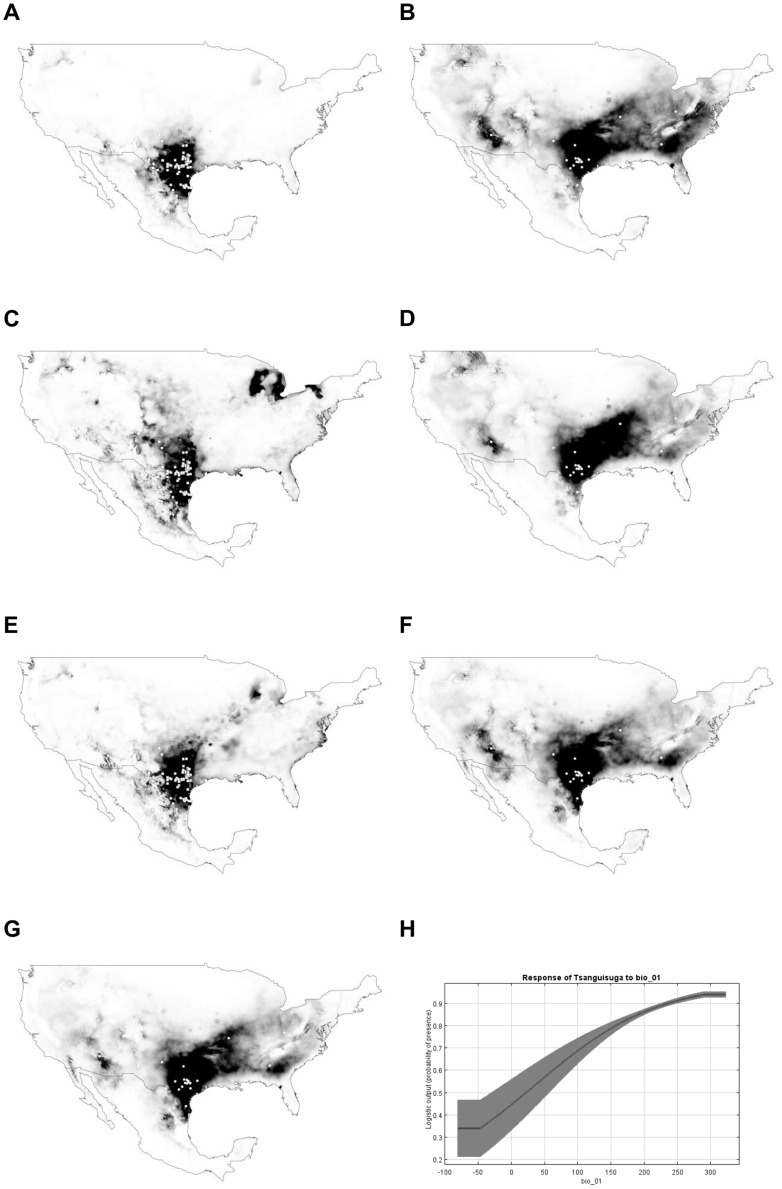
Present (A) and future (2050; B–G) potential distribution for Triatoma sanguisuga.All models predict a shift in the distribution of this species towards northern and eastern regions of Mexico and USA. Black color =  high suitable habitat vs. white color =  no suitable habitat for the species. General circulation models and climatic scenarios: B =  CCCMA-A2A; C =  CCCMA-B2A; D = CSIRO-A2A; E = CSIRO-B2A; F = HADCM3_A2A; G = HADCM3_B2A. Variable with most contribution on the species distribution was Annual Mean Temperature (H), which as per the original data (www.worldclim.org) was multiplied by 10.